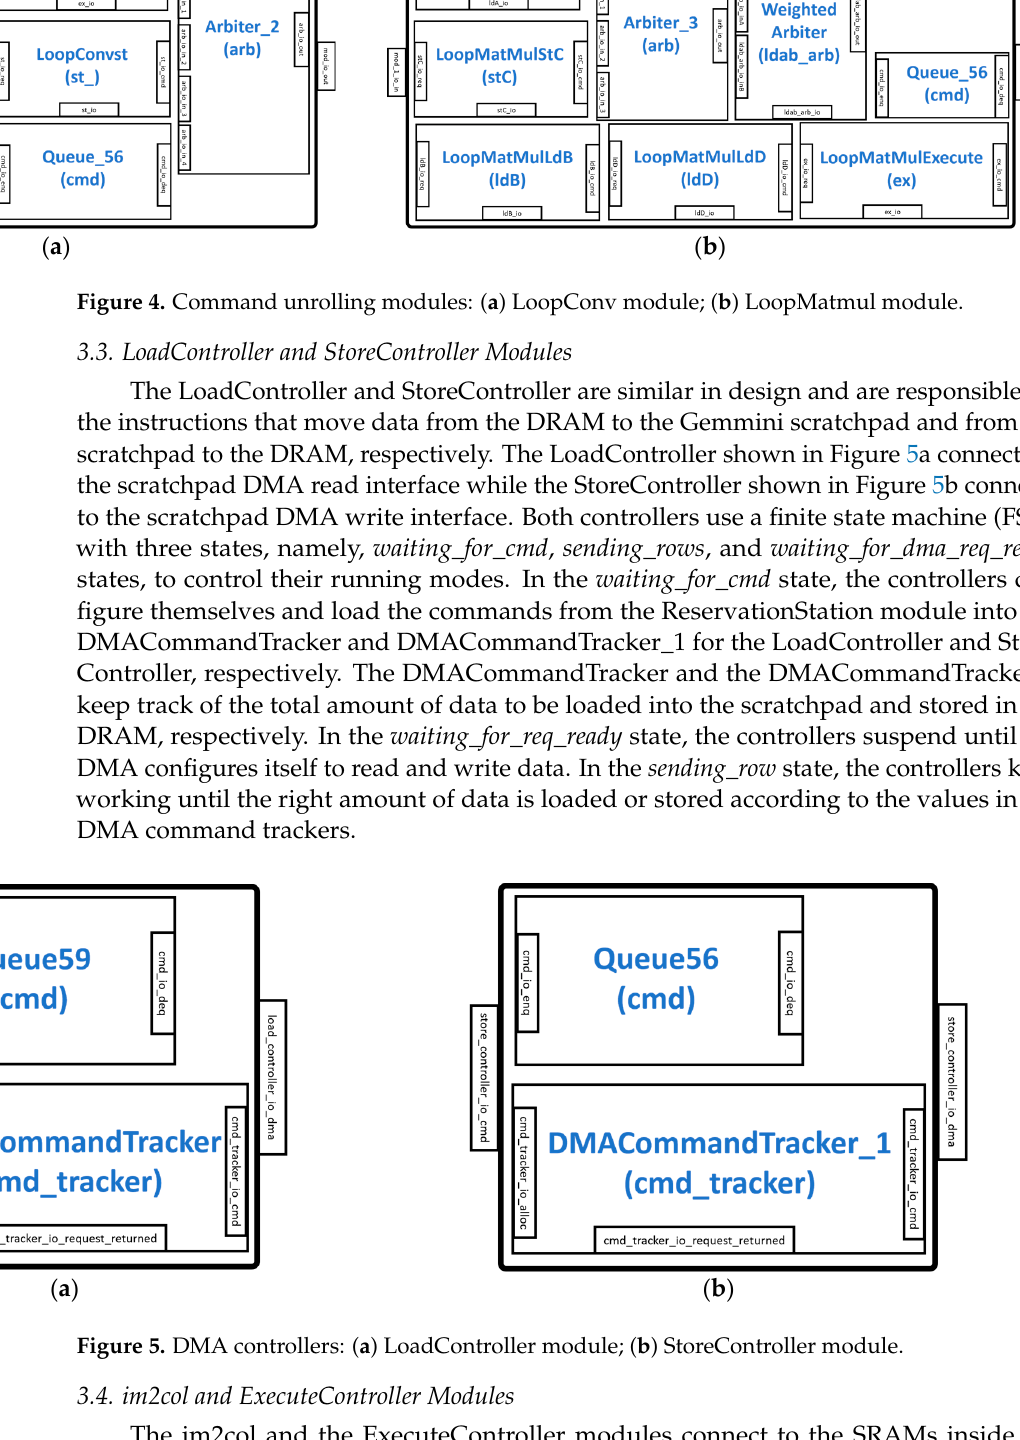
( b ) Figure 3. The RoCC interface: ( a ) the RoCC interface signals; ( b ) the RoCC command and response formats. 3.2. LoopConv and LoopMatmul Modules The LoopConv and LoopMatmul modules are responsible for unrolling large convo- lutions and matrix multiplications (matmuls), respectively, to fit the systolic dimension of DIM × DIM. The LoopConv shown in Figure 4a consists of modules, such as LoopCon- vLdBias, LoopConvLdWeight, and LoopConvLdInput, for signifying instructions for the convolution operation bias, weight, and input, respectively. The LoopConvExecute and LoopConvst modules are instructions for executing the convolution operation and storing results respectively. In the LoopMalmul module shown in Figure 4b, the LoopMat-